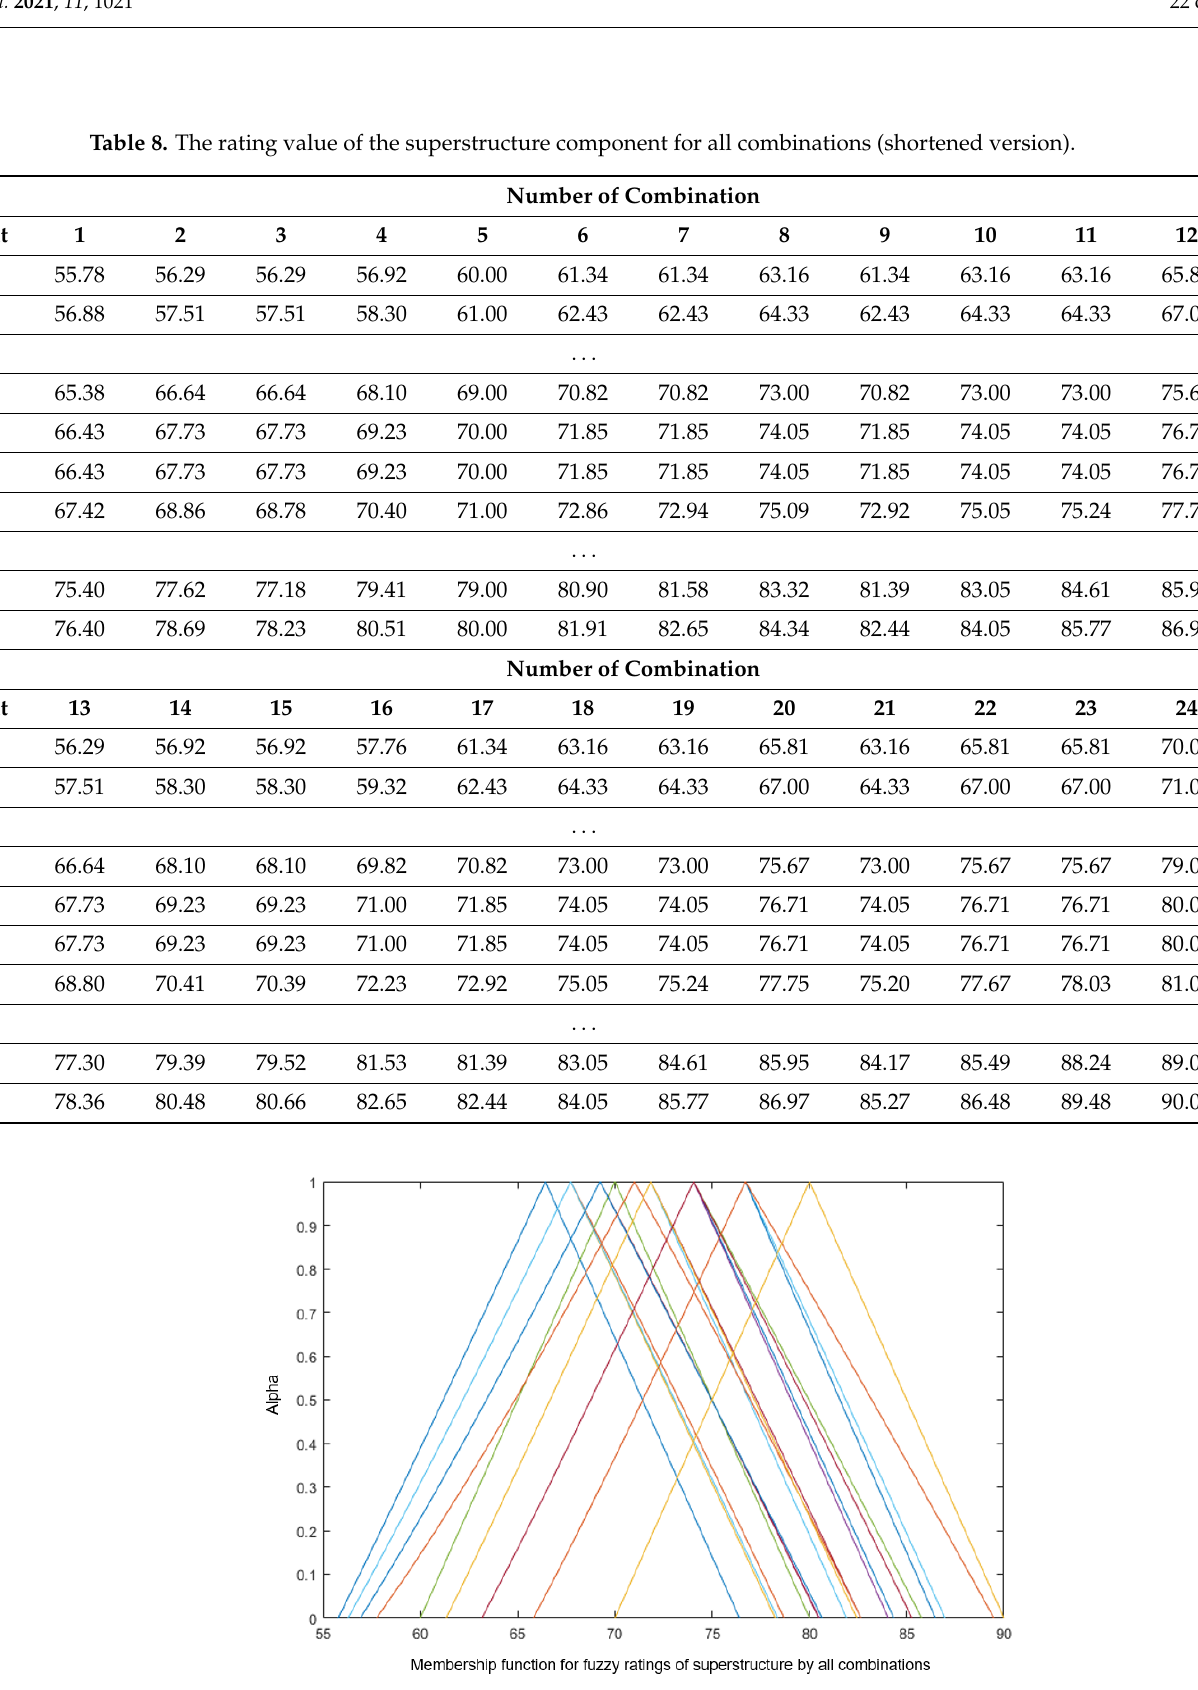
Table 9. The average of all combinations—the final fuzzy value of the superstructure component rating. α -Cut